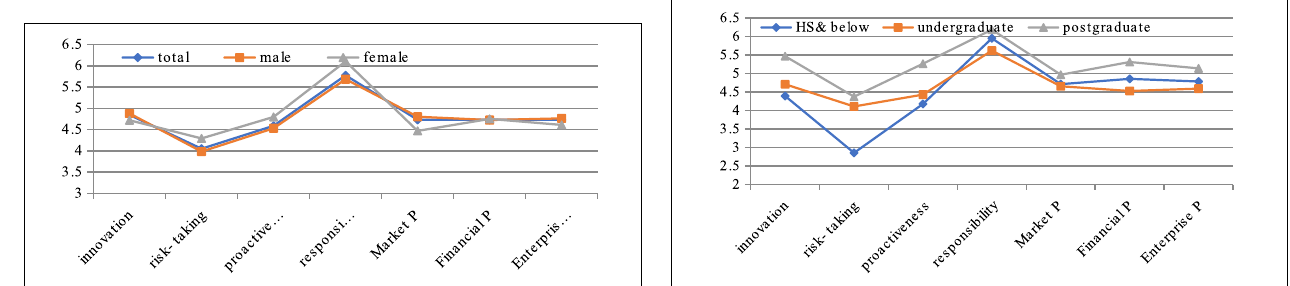
FIGURE 2 | Comparison of based entrepreneurial spirituality on gender. FIGURE 3 | Comparison of entrepreneurial spirituality based on